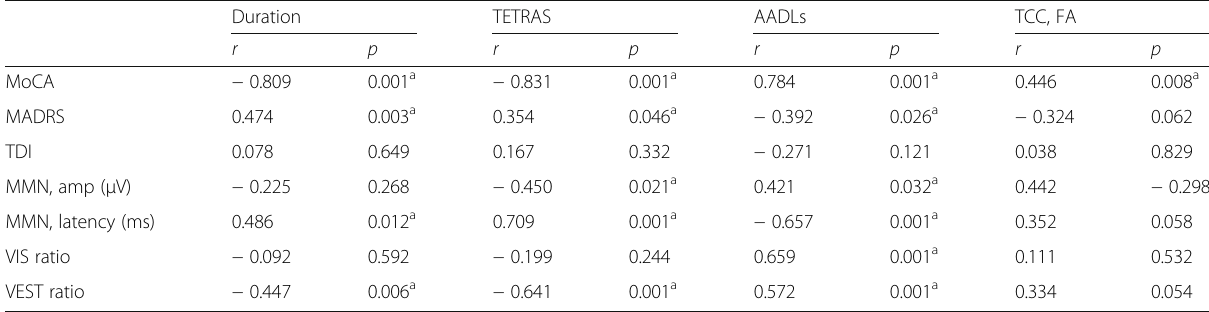
Table 2 Correlation of Modified Barthel Index score in included lacunar infarction patients 3 months after stroke onset with other studied baseline parameters Duration TETRAS